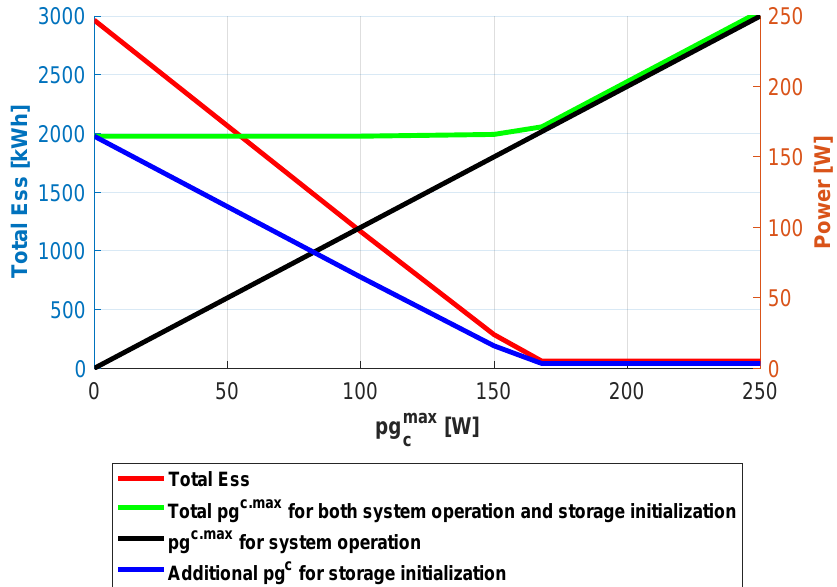
Figure 21. Power storage device capacity vs. power grid for the case α =